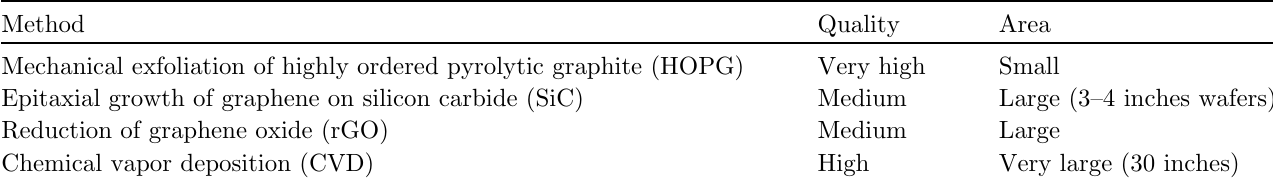
Table 1. The four methods of graphene